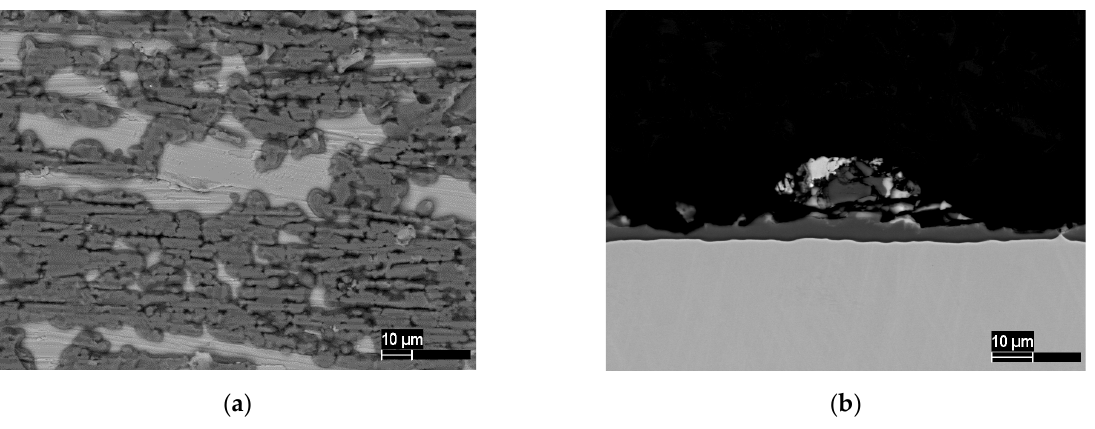
Figure 19. SEM images of the AISI 304/AA 6082 joint brazed according to the 540 °C/30 min mode. Different fracture views at 1000× magnification: ( a ) surface fractogram with z ‐ contrast; ( b ) cross ‐ section.